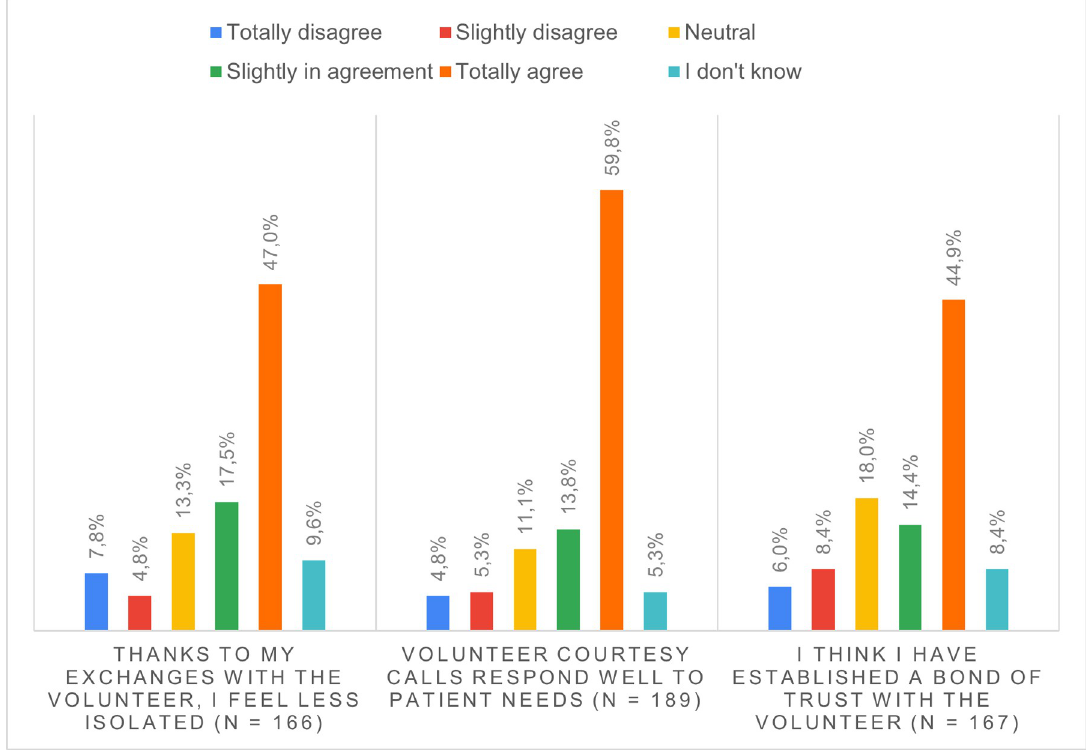
Fig 1. Patients’ perceptions of the volunteer courtesy phone calls.